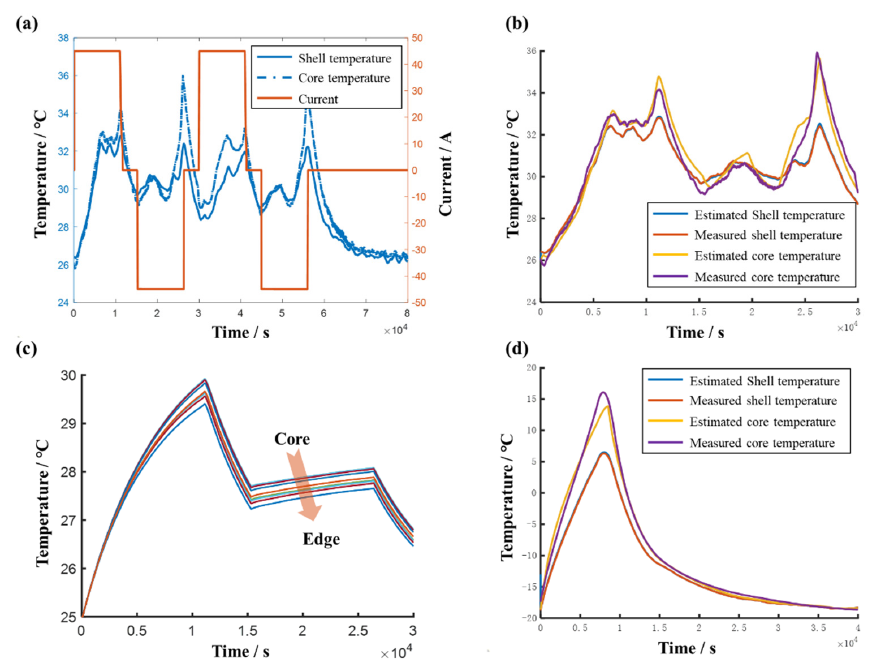
Figure 7. The experiment and simulation results of the thermal model. ( a ) Temperature measurement experiment results at 25 °C. ( b ) The validation of a single battery model at 25 °C. ( c ) Simulation results of the module model. ( d ) The validation of a single battery model at − 20 °C.